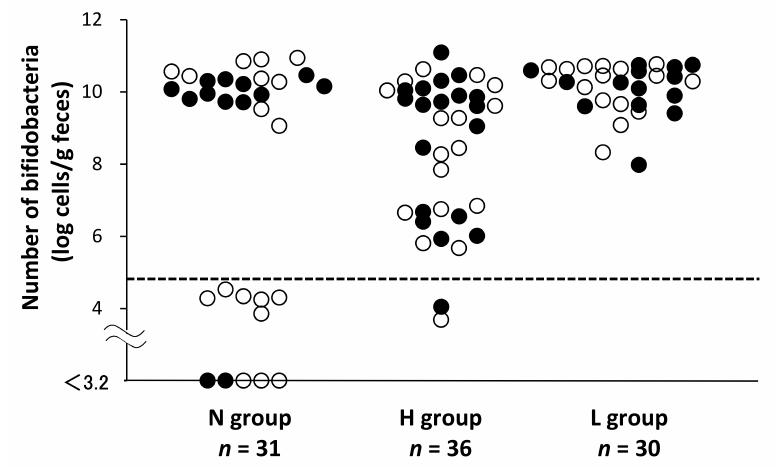
Figure 3. Impact of OLB6378 administration on fecal bifidobacterial counts at 1 month of age. N group, non-intervention control; H group, non-live OLB6378; L group, live OLB6378. The solid dots ( (cid:8) ) indicate infants who infants received first colostrum within 48 h of birth, and circles (O) indicate infants that received first colostrum more than 48 h after birth. The horizontal dotted line indicates the representative value of the lower limit of the 95% confidence interval of the bifidobacterial counts in Japanese term infants [30]. Compared with the N group, both the H and L groups had a significantly high proportion of “rich bifidobacteria” infants ( p < 0.05, by Ryan’s method). One sample in the H group was excluded owing to the lack of microbial DNA from the stool